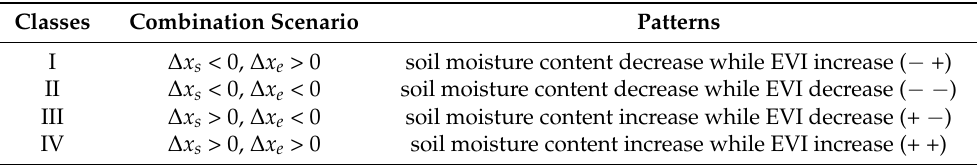
Table 3. Division of EVI variation trend coupling with soil moisture content variation trend patterns in the paired years under similar precipitation conditions.